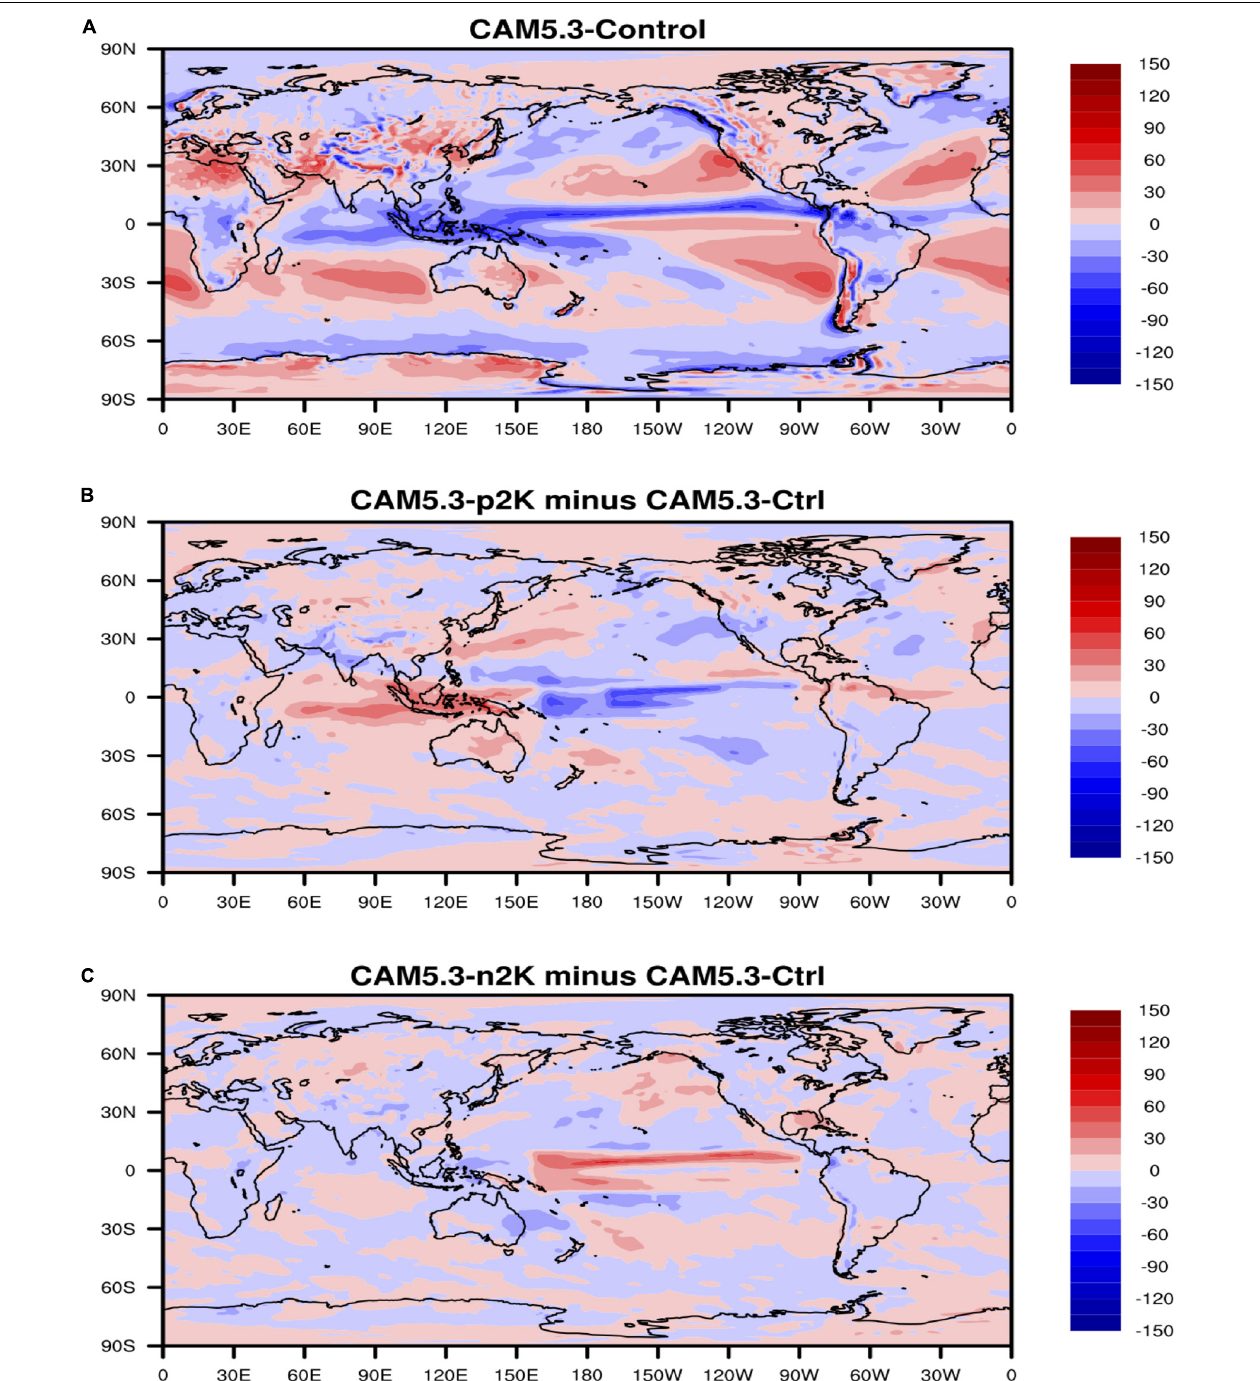
FIGURE 14 | (A) 500 hPa vertical velocity in the CAM5 control run. (B) Anomalies of 500 hPa vertical velocity in the CAM5 + 2K run with respect to the control run. (C) Anomalies of 500 hPa vertical velocity in the CAM5-2K run with respect to the control run. Unit of 500 hPa vertical velocity is